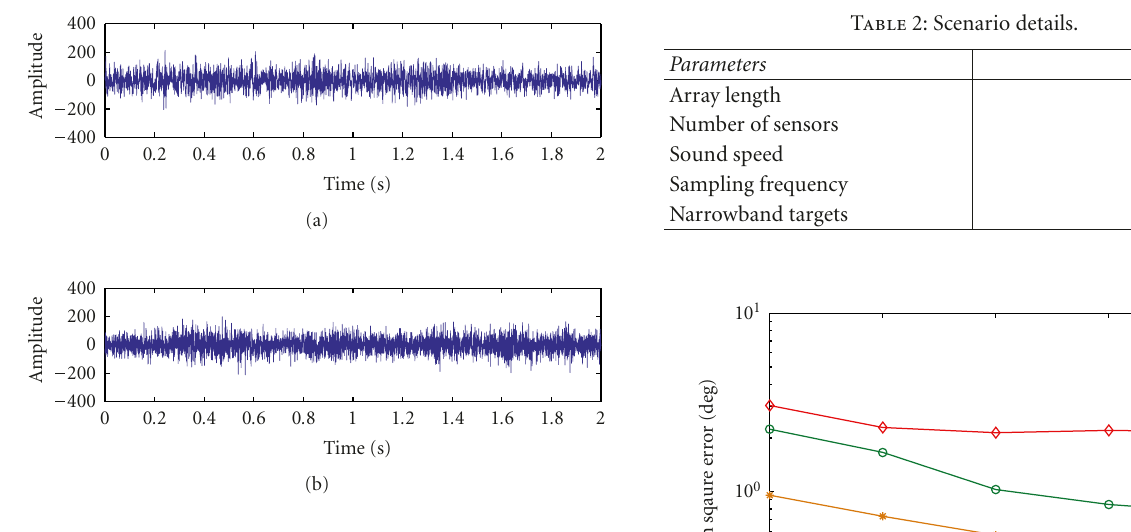
Figure 5: Underwater noise and simulated GARCH(1,1) time se- ries. (a) Measured additive noise, (b) GARCH(1,1) with α 2 0 = 343 . 6, α 2 1 = 0 . 84, and β 2 1 = 0 . 06.